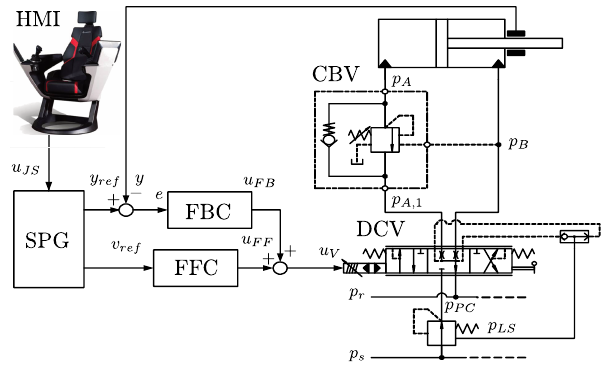
Figure 2: EHC motion control sub-system. Image courtesy of Bak and Hansen